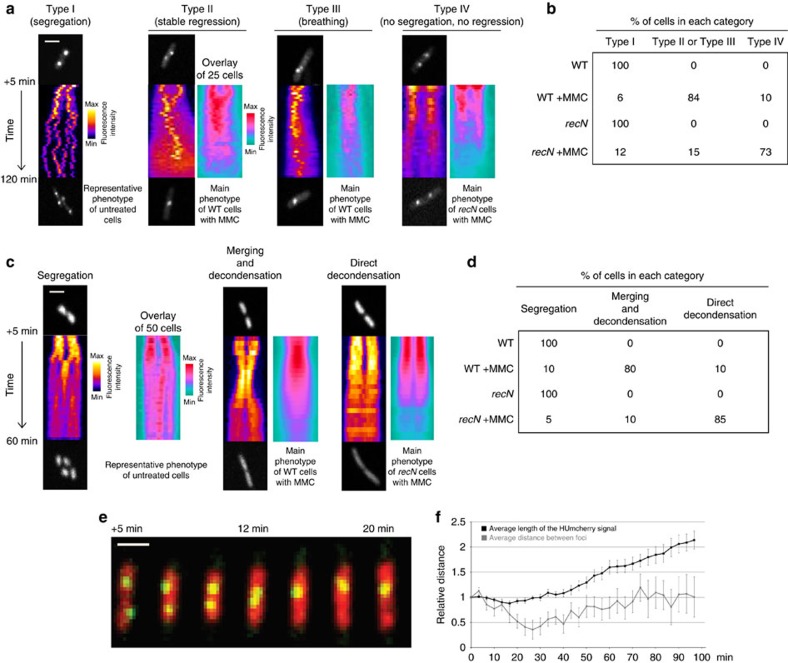
RecN participates in sister locus re-pairing and nucleoid rearrangement in response to DSBs.(a) Representative kymographs of sister focus dynamics in the absence or presence of MMC. Kymographs were constructed along the long axis of the cell. Time-lapse imaging starts 5 min after the initial contact with MMC. Images were acquired every 3 min for 2 h. The fire lookup kymographs represent a single cell. The Ice lookup kymographs are an overlay of kymographs. (b) Frequency of the different types of sister focus dynamics was measured in the presence of MMC. Results are expressed as a percentage. About 100 cells were observed. (c) Representative kymographs of nucleoid (HU-mCherry) dynamics in the absence or presence of MMC. (d) The frequency of the different types of nucleoid dynamics was measured in the presence of MMC for the WT strain and the recN mutant. Results are expressed as a percentage. About 100 cells were observed. (e) Dynamics of sister foci and nucleoids in the presence of MMC. A time course was performed in a strain tagged with a parSpMT1/ParB tag at ori-3 and labelled with HU-mCherry. (f) The distance between nucleoid edges and the distance between sister foci were recorded at each time point of the experiment presented on e. Distances were normalized to 1 for the time +5 min after MMC addition and are an average of 50 cells. Error bars are standard deviations of 50 cells. Scale bars are 1 μm.